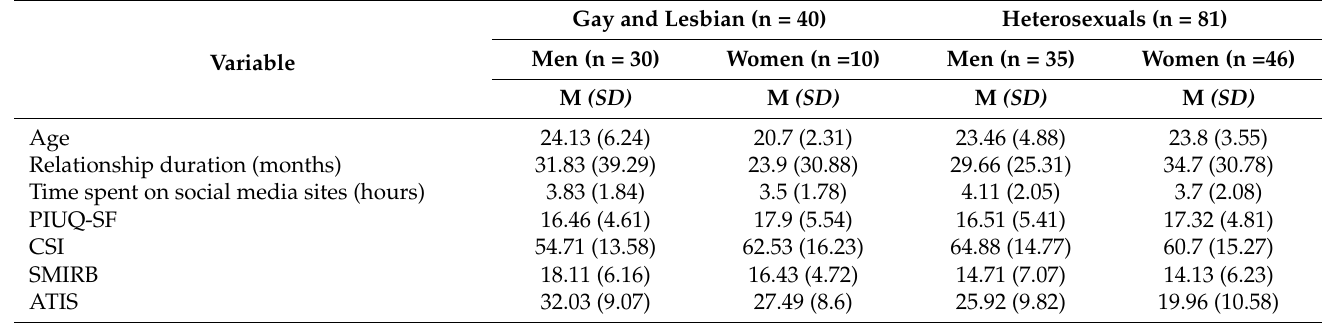
Table 2. Descriptive statistics (means and standard deviations) from non-transformed